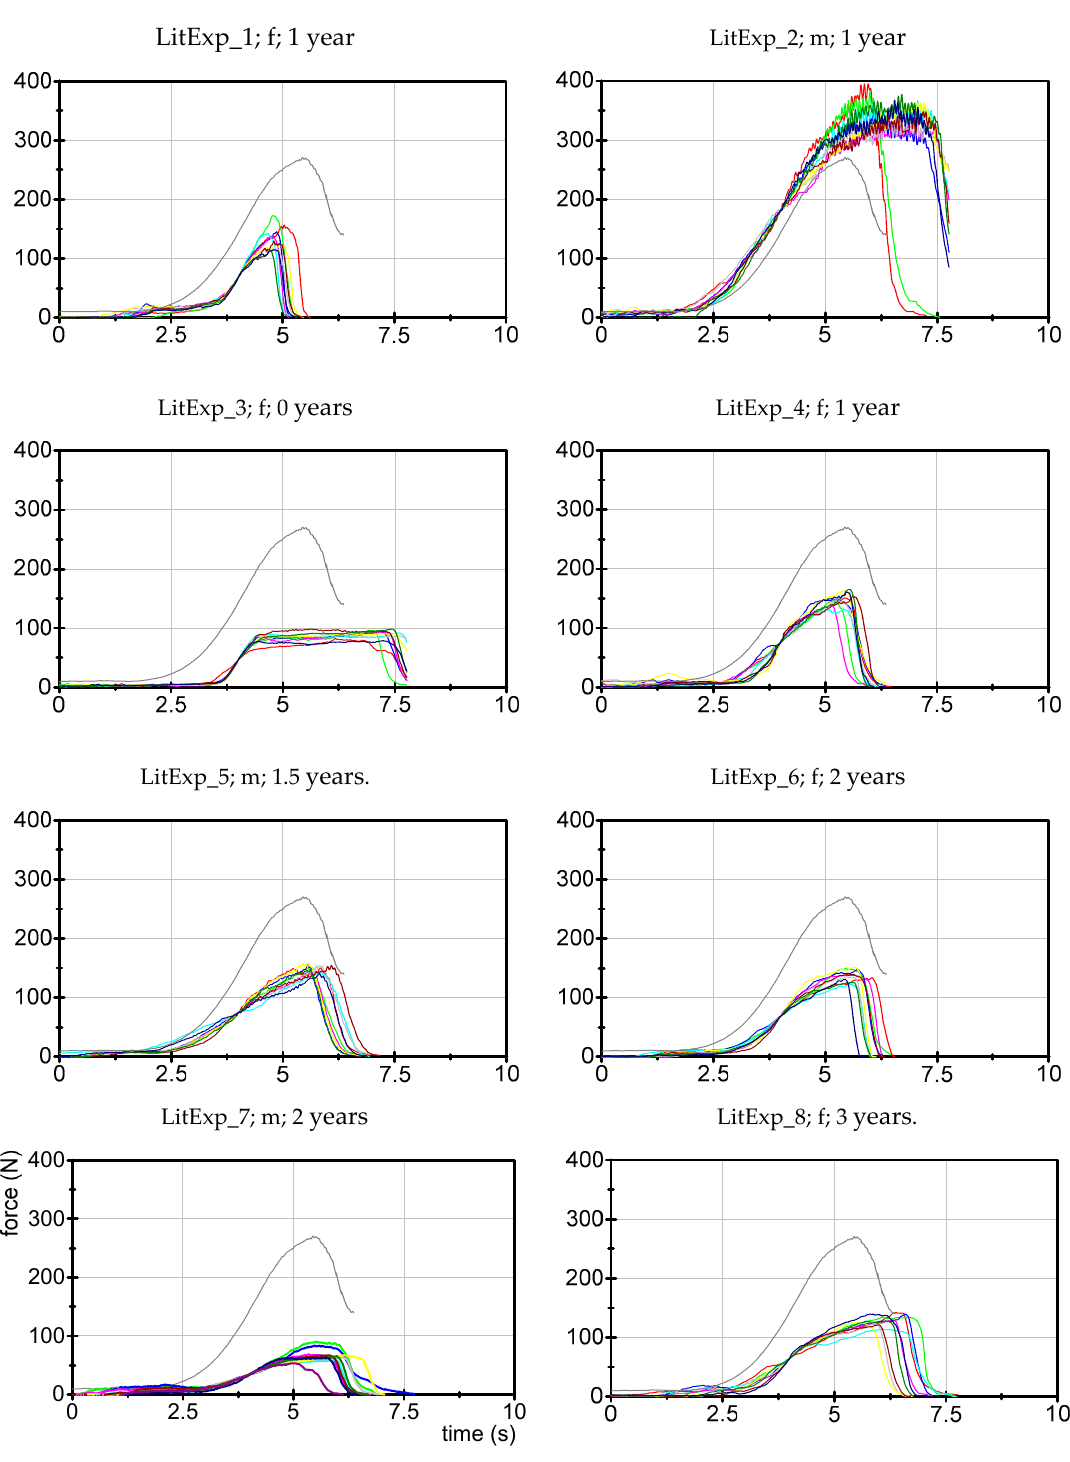
Figure 4. Force profiles of little experienced testers. Displayed are the 10 individual force profiles of the n = 8 little experienced testers (LitExp). The grey curve displays the suggestion of a standardized force profile (see discussion). To have a better comparison, the x - and y -axes are standardized (0–10 s and 0–400 N). The ID (LitExp_no.), gender (f = female, m = male) and the years of experience are given per tester. The one tester with zero years of experience had successfully participated at the basis course of “Applied-Kinesiology based Integrative Medicine” in 2019 (3 month prior to measurement) and since then practices with colleagues.